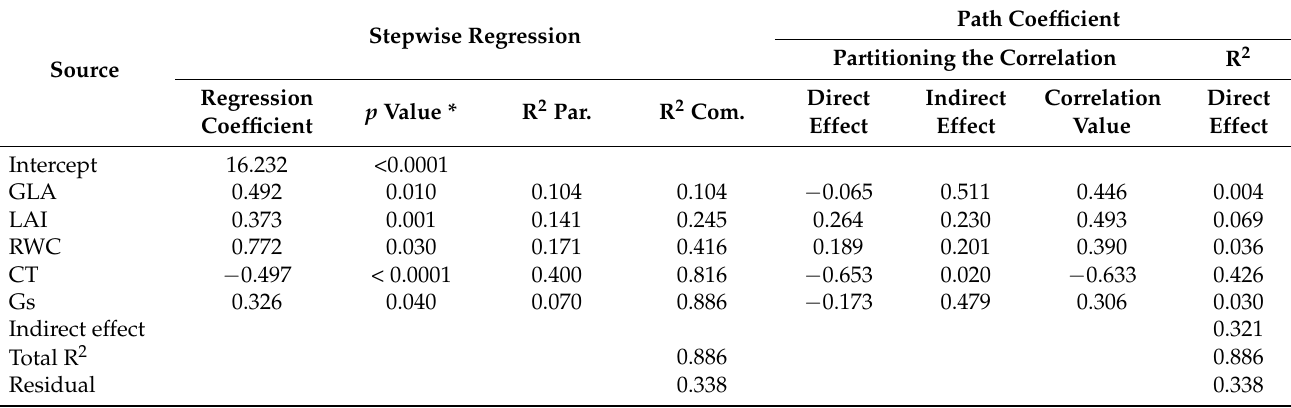
Table 5. Stepwise regression and path coefficient analyses for grain yield (dependent variable) with four yield-related traits (independent variables) for combined data across the two seasons under full and limited irrigation